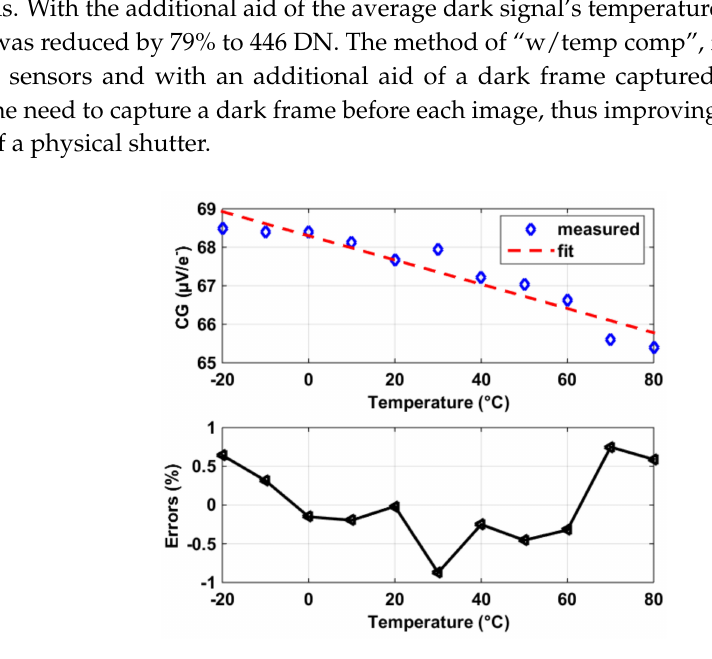
Figure 15. Measured conversion gain (CG) versus temperature in our CIS ( top ) and the deviations between the measurements and their fit ( bottom